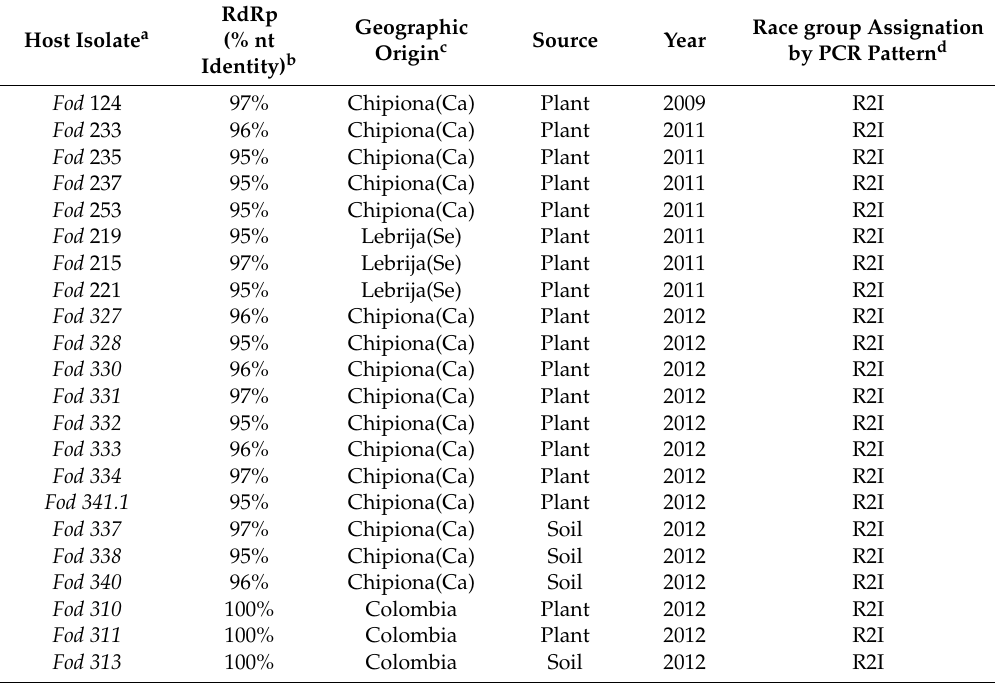
Table 3. Isolates of Fusarium oxysporum f. sp. dianthi infected with mitovirus FodMV1.